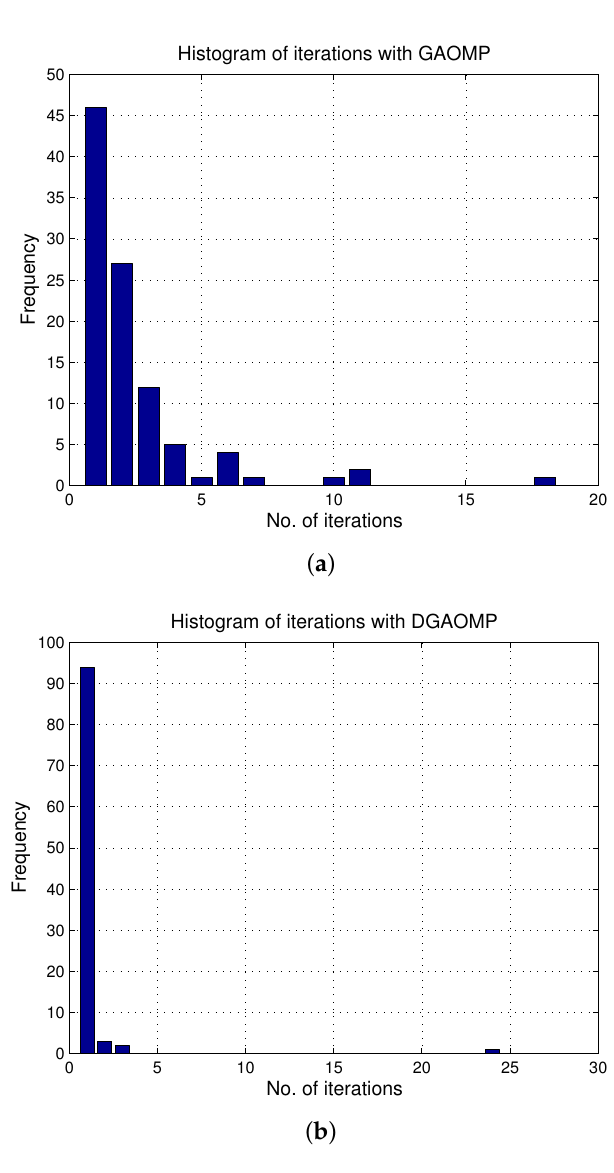
Figure 8. ( a ) Histogram of iterations for GAOMP. The success rate for single iteration is around 45%. One iteration represents three repetitions of the OMP algorithm; ( b ) Histogram of iterations for the technique of DGAOMP. The success rate for single iteration is more than 90%. One iteration represents three repetitions of the OMP